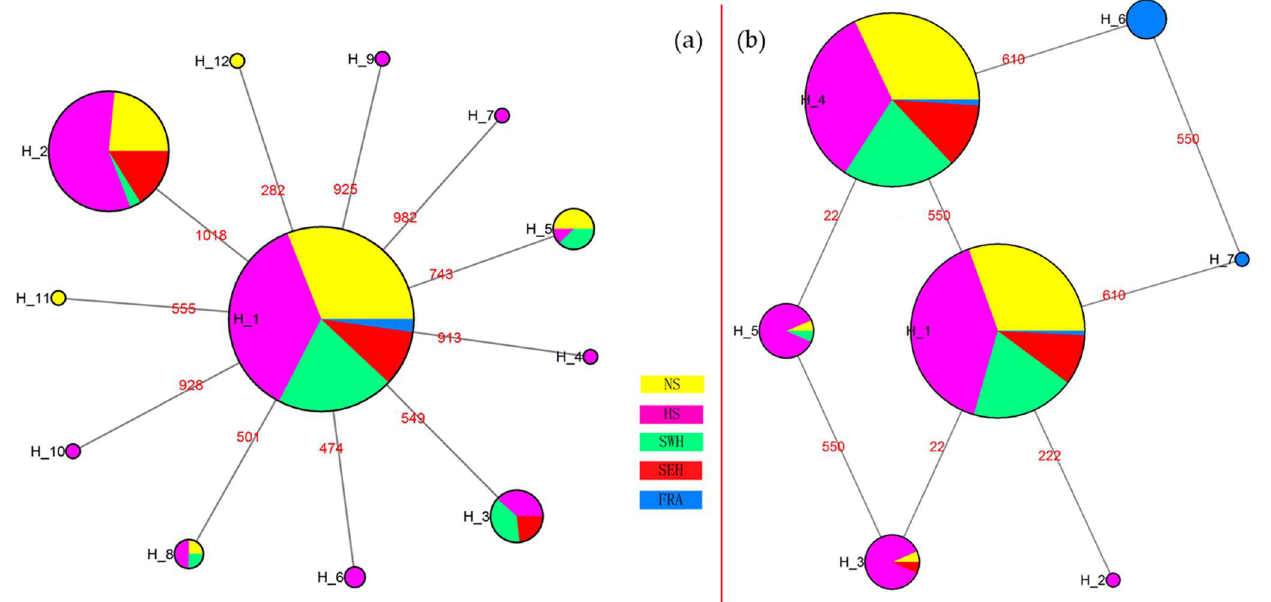
Figure 7. Haplotype network of R. maidis in China and France. ( a ): The combined COI and COII genes, H_1 to H_12 represent HRm1 to HRm12; ( b ): the EF−1α gene, H_1 to H_7 represent HRm1 to HRm7. The area of the circles represents the number of individuals sharing the haplotypes. The red numbers indicate the nucleotide positions of polymorphic sites between two haplotypes. NS, north spring maize region in China; HS, Huanghuaihai summer maize region in China; SWH, southwest hilly maize region in China; SEH, southeast hilly maize region in China; FRA, maize region in France.